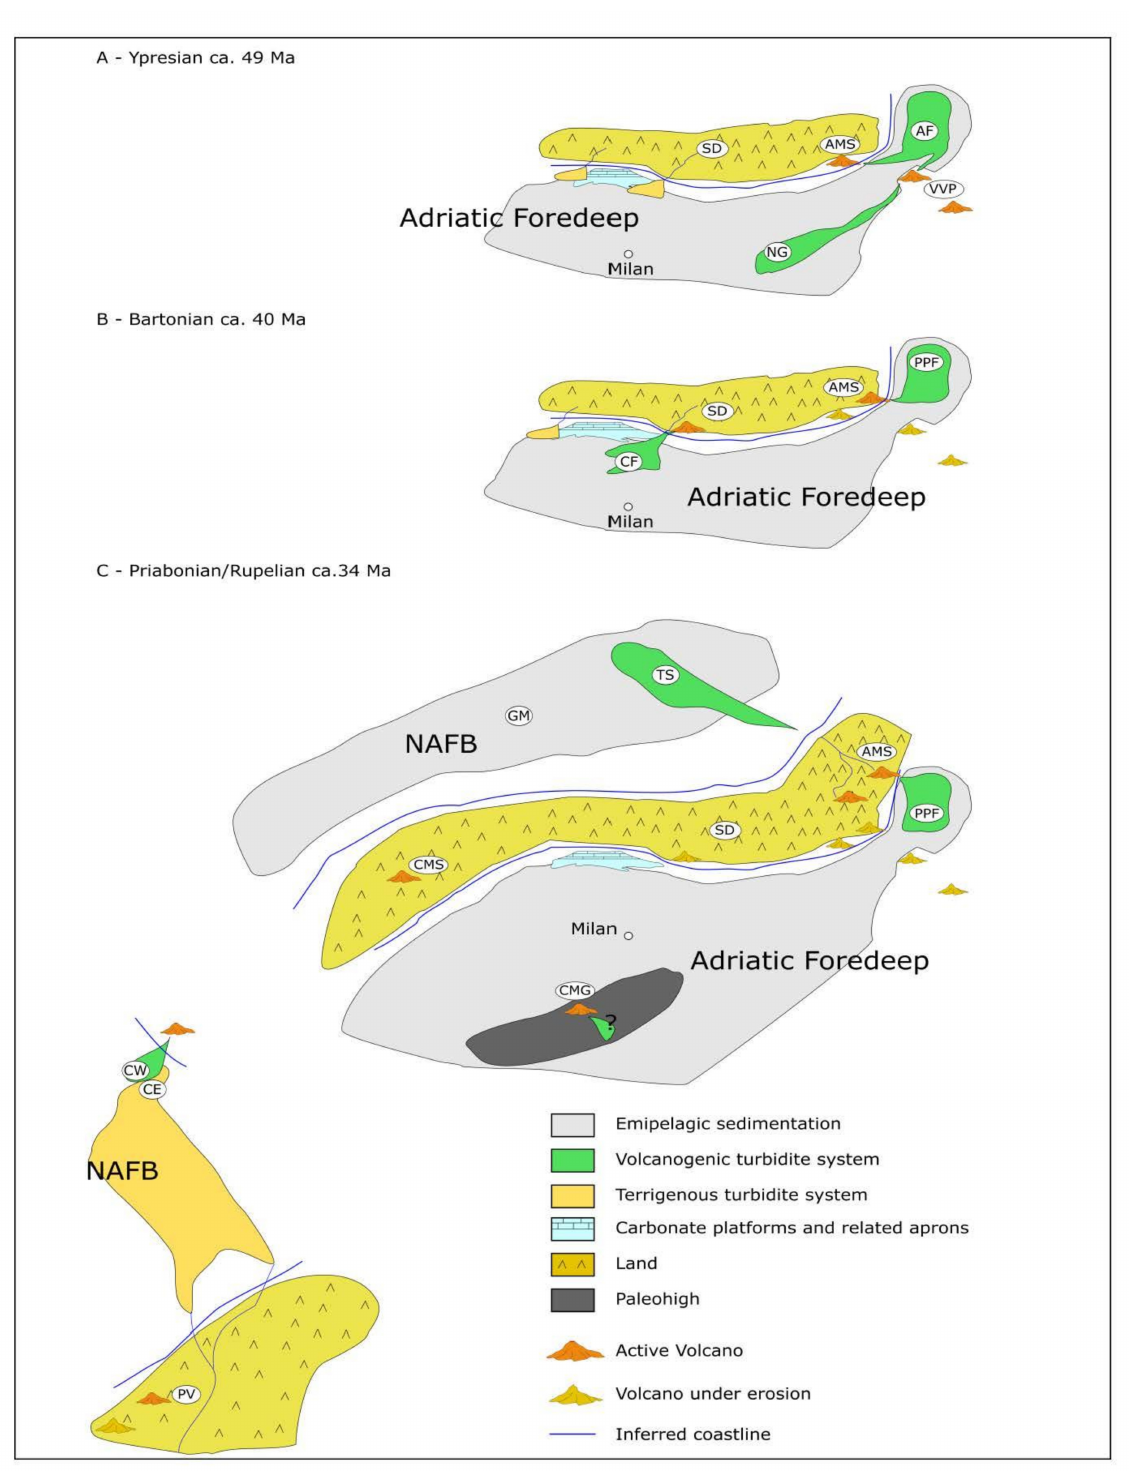
Figure 8. Paleogeographic reconstruction of the source-to-sink systems around the Alps during the Ypresian (ca. 49 Ma - SD = southalpine dykes; AMS = Adamello Magmatic System; AF = Val d’Agola Formation; VVP = Venetian Volcanic Province; NG = Gallare Marls), during the Bartonian (ca. 40 Ma, CF = Cibrone Formation; PPF = Ponte Pi à Formation), and during the boundary between Priabonian and Rupelian (ca. 34 Ma, NAFB = Northern Alpine Foreland Basin; TS = Taveyanne Sandstones; GM = Globigerina Marls; CMS = Biella Magmatic System; CMG = Cerano-Mortara-Garlasco volcano; CW = Western Champsaur; CE = Eastern Champsaur; PV = Provence